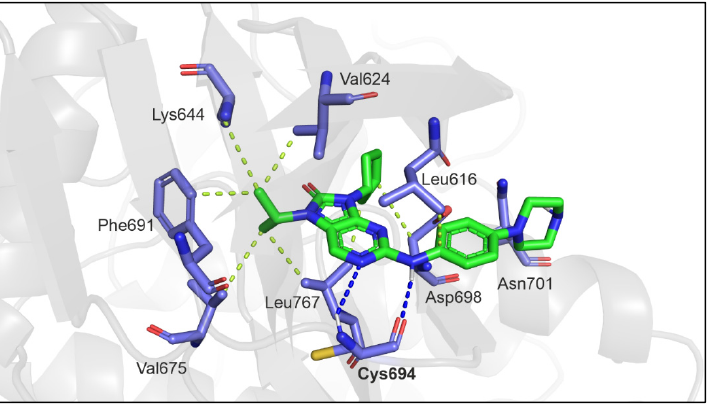
Figure 3. Binding pose of 15a (green sticks) in the model of FLT3. The kinase is shown in gray with interacting residues shown as blue sticks. Heteroatoms are blue (nitrogens), red (oxygens), yellow (sulfur), and white (hydrogens).